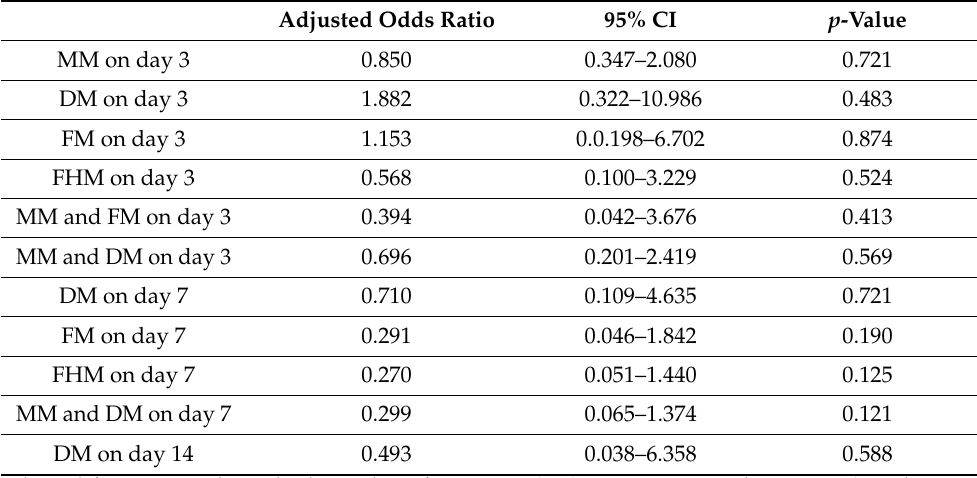
Table A5. Relationship between feeding strategies and NEC adjusted for demographic variables: results from Logistic regression model on days 3, 7, and 14,